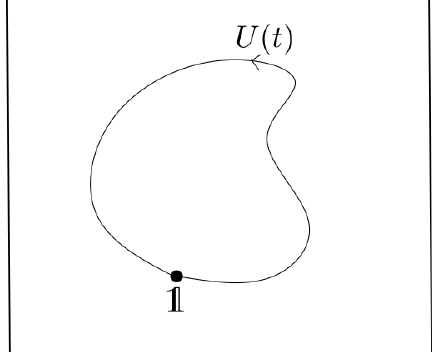
Figure 4: An example illustrating the difference between path integral cost and op- erator complexity. Suppose we have a manifold M such that Hamiltonian evolution from the initial to final boundary traces out a closed path through the space of uni- tary operators, i.e. a Poincaré recurrence with e iHt f ≈ 1 . The path integral cost